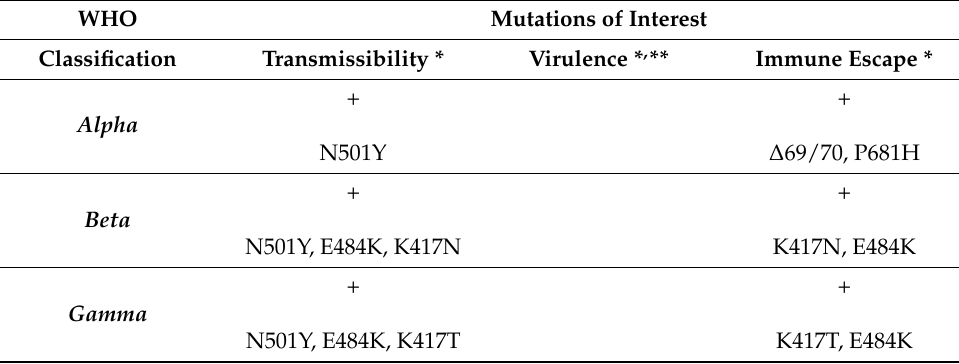
Table 1. SARS-CoV-2 major Spike amino-acid substitutions and their virological and clinical impacts.